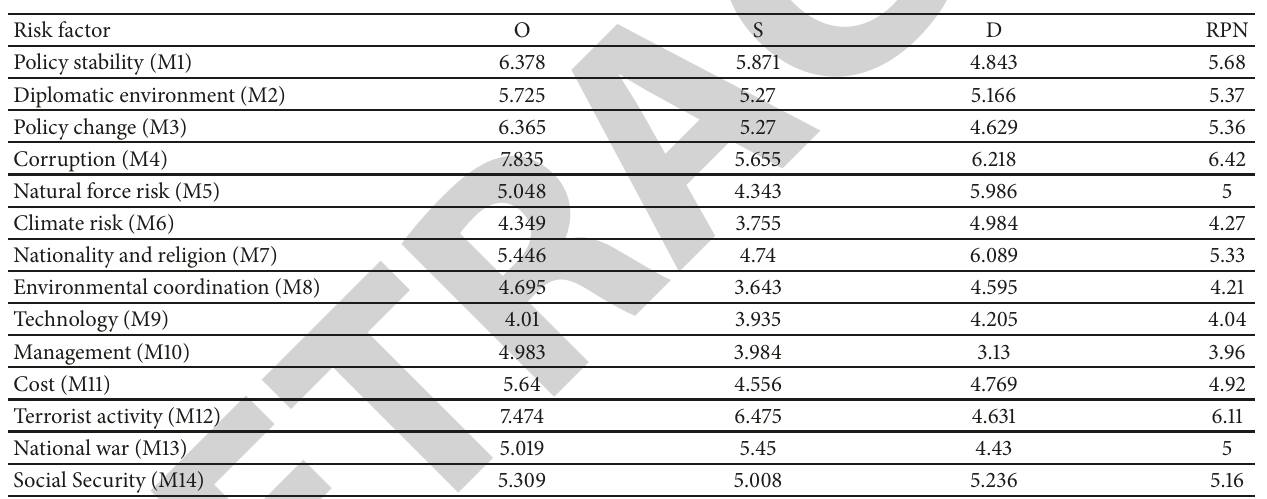
Table 5: Linguistic weighting